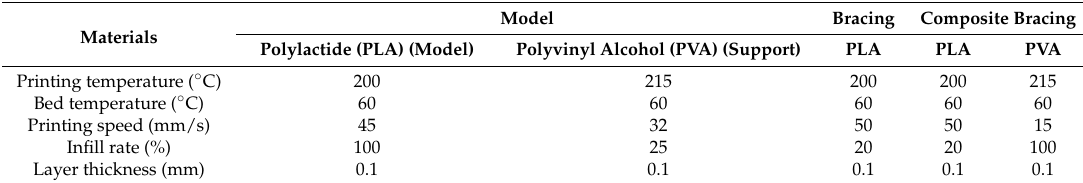
Table 1. Primary settings for 3D printing.